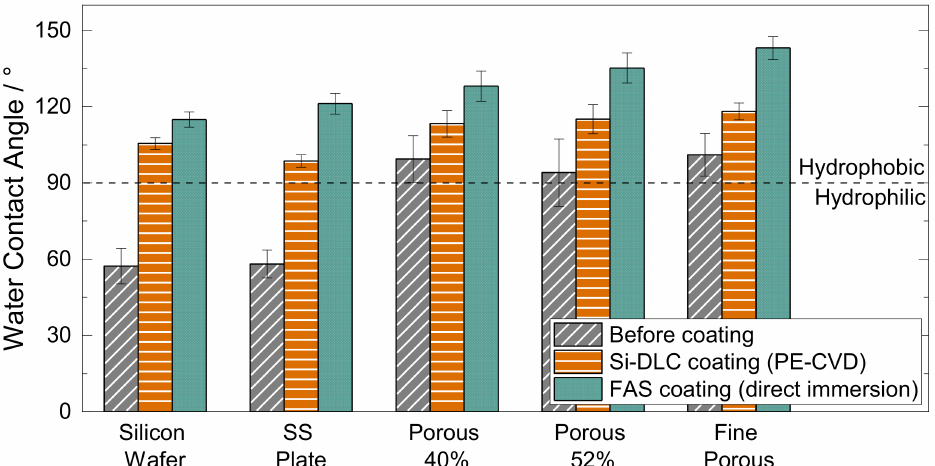
Figure 8. The average contact angle for the different substrates: before coating (grey), after Si-DLC coating (orange) and after FAS coating